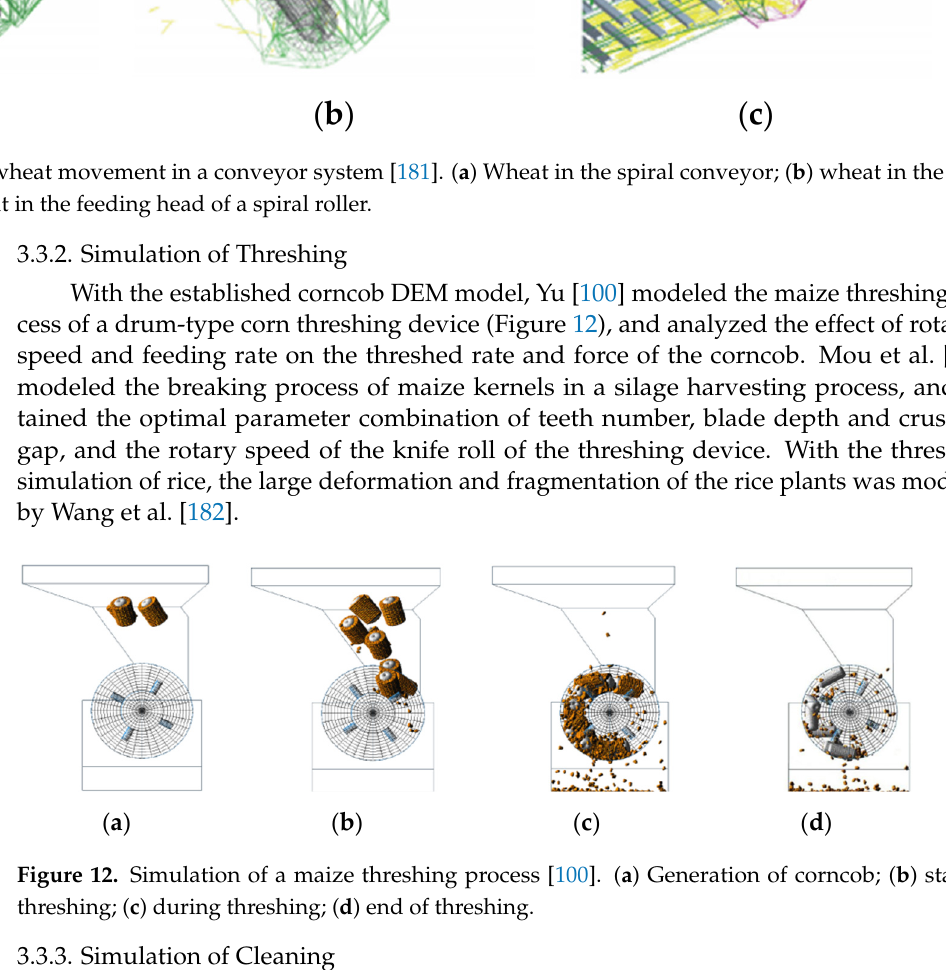
Figure 11. Simulation of wheat movement in a conveyor system [181]. ( a ) Wheat in the spiral conveyor; ( b ) wheat in the incline conveyor; ( c ) wheat in the feeding head of a spiral roller.